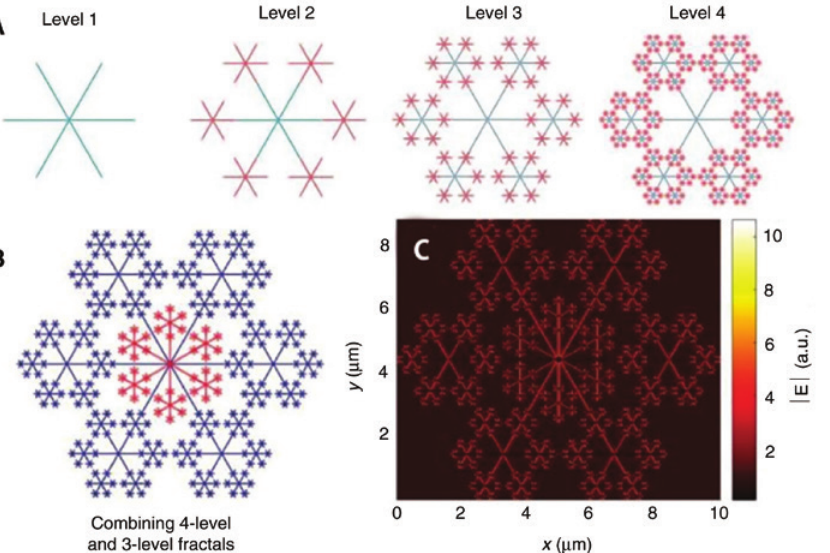
Figure 2: Construction of the branching generated by recursive iterations. (A) Construction of the fractal design with “snowflake” geometry from levels 1–4. (B) Total structure comprising four-level (blue) and three-level (red) fractals used in the study. (C) Finite-difference time- domain simulated in-plane electric field (of the incident electromagnetic wave) distribution just underneath the Au fractal metasurface on a glass substrate under the excitation wavelength of 530 nm. The electric field is linearly polarized along the y -direction. Reproduced with permission from Ref.